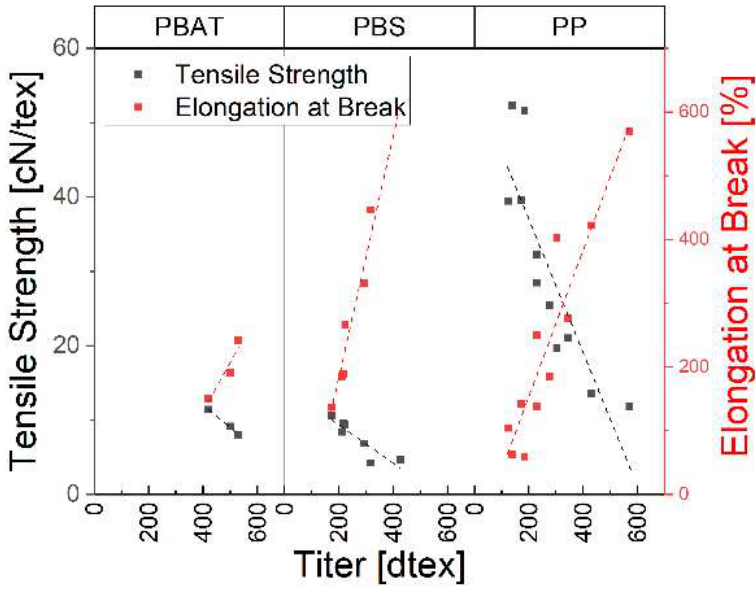
Figure 14. Tensile strength and elongation at break over titer for three polymer fibers. The ODR and tensile strength of the spun fibers showed similar behavior when plotted against the titer (Figure 15). This is because finer fibers are obtained at higher draw ratios and have a higher tensile strength.